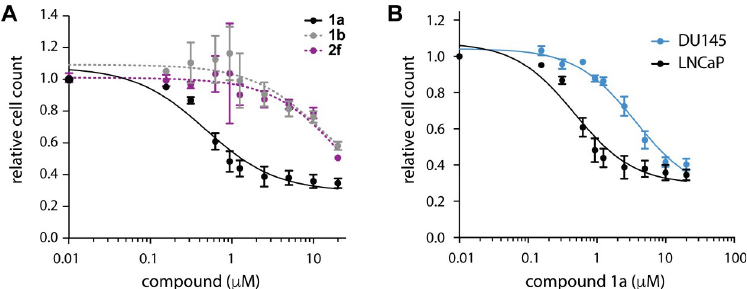
Fig 6. Treatment of prostate cancer cell lines with ENTPD5 inhibitors. A) Growth of LNCaP cells treated with compound 1a , 1b , or 2f for 48h. 1a EC 50 : 0.47 ± 1.28 μ M; 1b EC 50 : 12.9 ± 3.3 μ M; 2f EC 50 : 24 ± 3 μ M. B) Growth of LNCaP and DU145 cells treated with compound 1a for 48h . 1a EC 50 in DU145: 3.6 ± 1.2 μ M; 1a EC 50 in LNCaP: 0.47 ± 1.28 μ M. Relative cell count was normalized to DMSO-treated cell counts. Error bars represent standard error of the mean between three independent experiments.